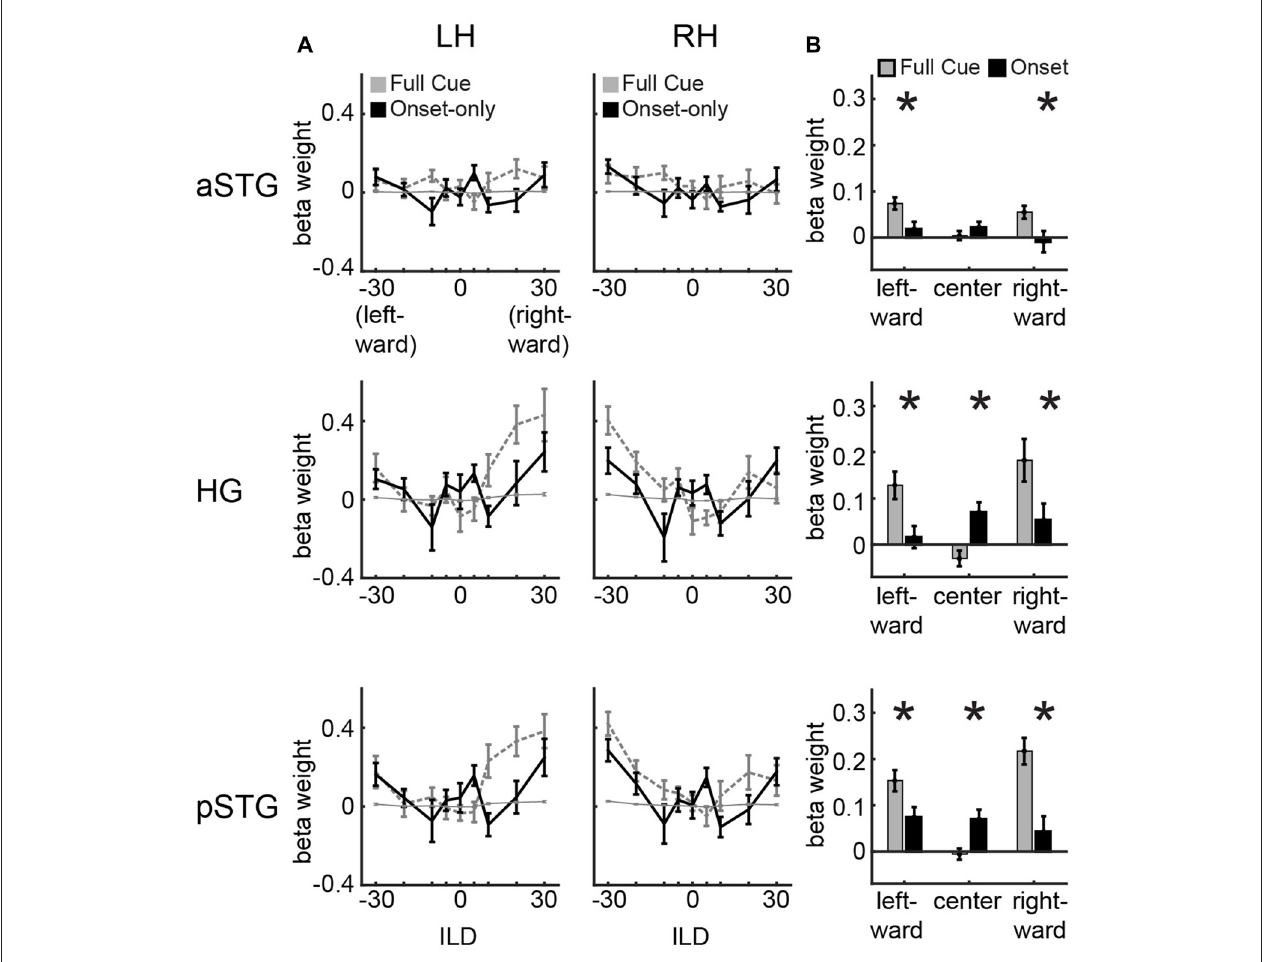
FIGURE 2 | Univariate results. (A) Univariate ILD tuning functions plot average beta weights for all voxels in left and right hemisphere for aSTG, HG and pSTG in response to sounds varying in ILD in the full-cue (veridical lateralization; dashed gray lines) and onset-only (illusory lateralization; black lines) conditions. Thin gray line depicts 1/16th of the full-cue tuning function, indicating the hypothetical response to the physical features of the onset-only sound. (B) Average of beta weights across left and right hemisphere in response to leftward ( − 30, − 20, − 10 dB ILD), center ( − 5, 0, +5 dB ILD) and rightward (+10, +20, +30 dB ILD) sounds for the full-cue (gray) and onset-only (black) stimuli. Error bars reflect SEM across participants. Asterisks reflect significant difference based on paired t -test ( p < 0.05; FDR